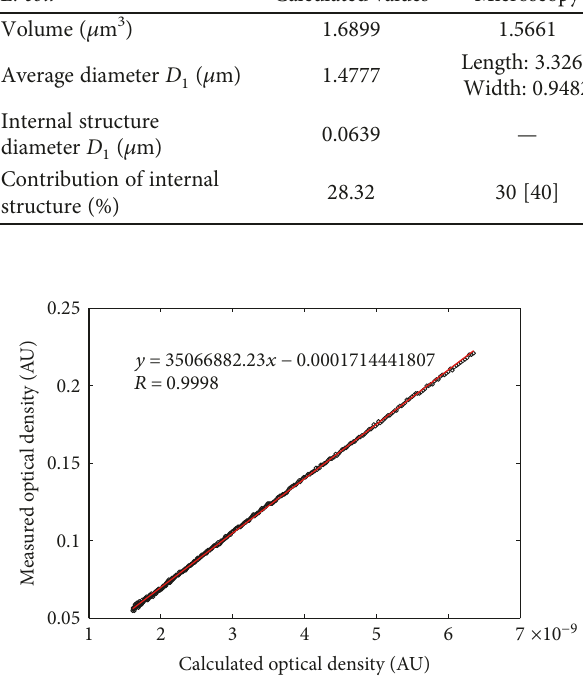
Figure 3: Plot of measured optical density as a function of a single bacterial optical density, the continuous line corresponds to a fi tting using (8).